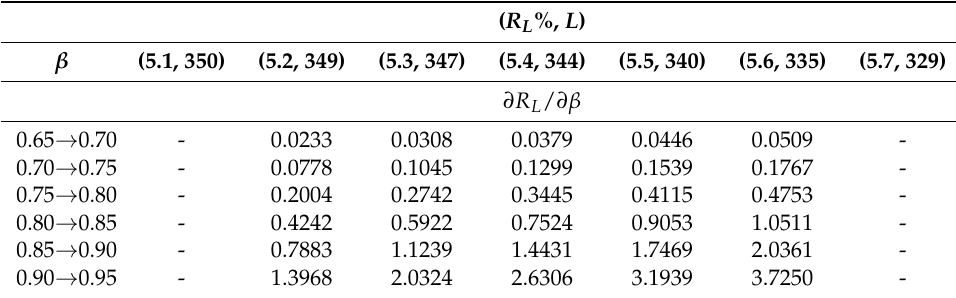
Table 3. Responsiveness of bank interest margin to barrier 1 .